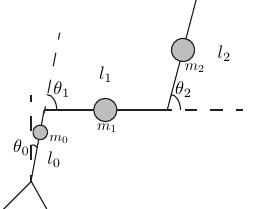
Figure 2: Three link model for the lower body